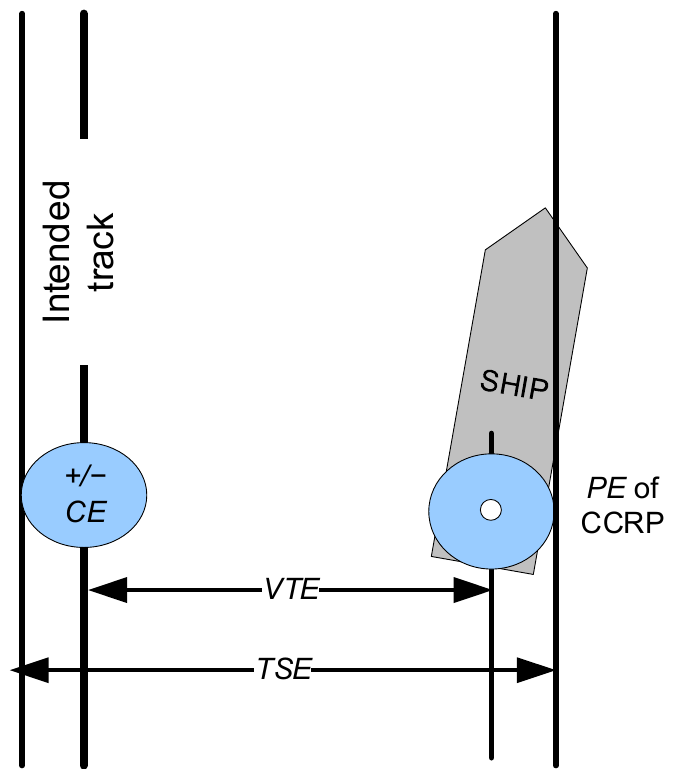
Figure 1. Contribution of GNSS position error ( PE ), chart error ( CE ), and vessel technical error ( VTE ) to total system error ( TSE ) according to [13] (own visualization).